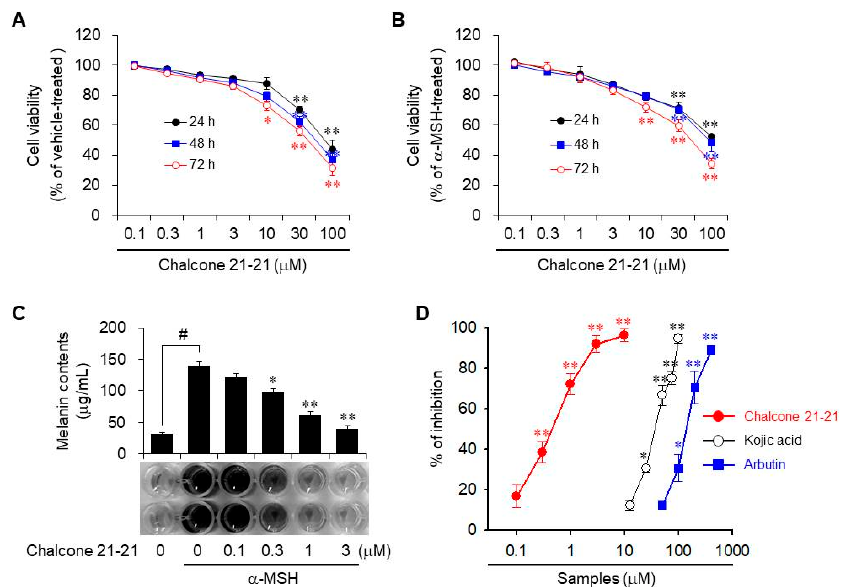
Figure 2. Chalcone 21-21 inhibits melanin production. ( A , B ) B16F10 cells were incubated for the indicated time-intervals with vehicle (0.1% DMSO) alone or various concentrations of chalcone 21-21 in the absence or presence of α -MSH (10 nM). Cell viability was measured using the EZ-CyTox Enhanced Cell Viability Assay Reagent, and is represented as % control compared to the vehicle alone-treated group. Results are represented as mean ± SD from three independent experiments ( n = 3). p -values of * p < 0.05 and ** p < 0.005 compared to the vehicle- or α -MSH-treated group were considered statistically significant. ( C , D ) Cells were incubated for 72 h as mentioned above in Figure 2B. Melanin contents ( C ) and inhibition percentage of melanin production ( D ) are shown. Results are represented as mean ± SD from three independent experiments ( n = 3). p -values of # p < 0.005 compared to the vehicle-treated group and * p < 0.05 and ** p < 0.005 compared to the α -MSH-treated group were considered statistically significant. Kojic acid and arbutin were used as positive